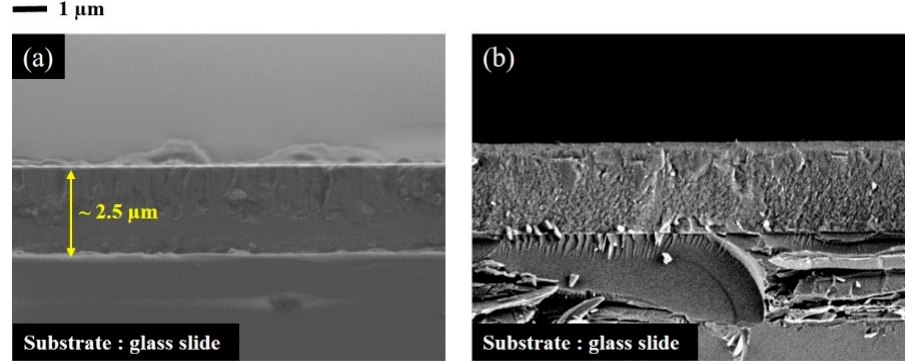
Figure 5. SEM cross-section observations of sample with 37 at.% Si deposited in Group I with R P < 7 × 10 − 4 Pa: ( a ) as-deposited and ( b ) annealed film in air at 180 °C for 2 h. An average of 2.5 µm was measured for the film